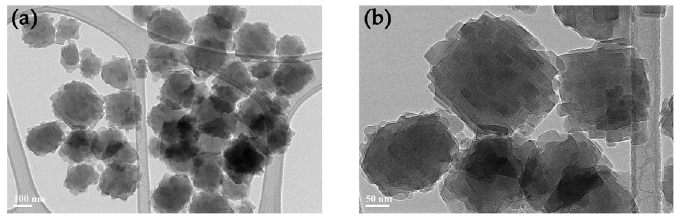
Figure 11. The panoramic ( a ) and enlarged TEM image ( b ) of ZSM ‐ 5 ‐ 100 ‐ 200. Table 1. Elemental composition and textural properties of ZSM ‐ 5 ‐ 50 ‐ 200 and ZSM ‐ 5 ‐ 100 ‐ 200. Sample